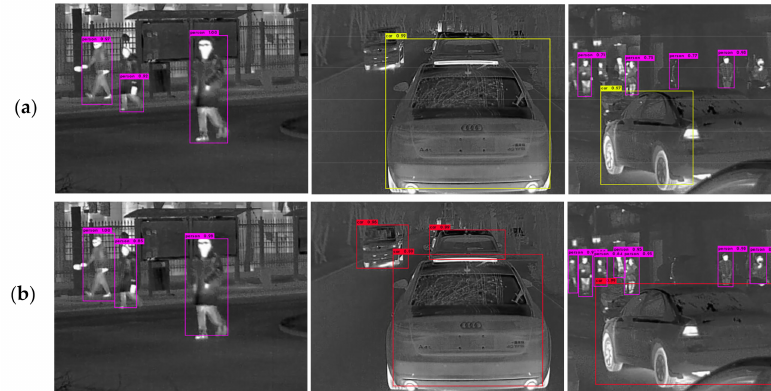
Figure 5. Comparison of the test results of our improved detector using different bounding box regression losses. ( a ) The joint detector with anchor-based branches of YOLOv3 using mean square error (MSE) loss and anchor-free branches of the FSAF module using IoU loss. ( b ) The improved detector using CIoU